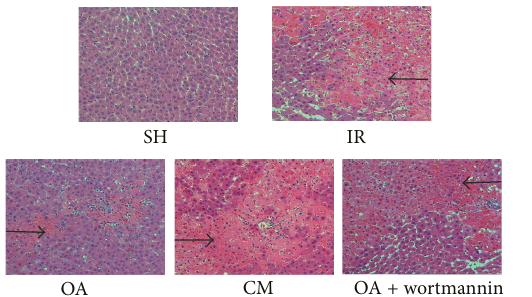
Figure 1: Effects of pretreatment with OA on partial hepatic IR injury evaluated by histological examination of rat liver tissue. The sections of the five groups were prepared at 6h after reperfusion (HE, × 400). Arrows indicate necrotic areas of liver tissue.